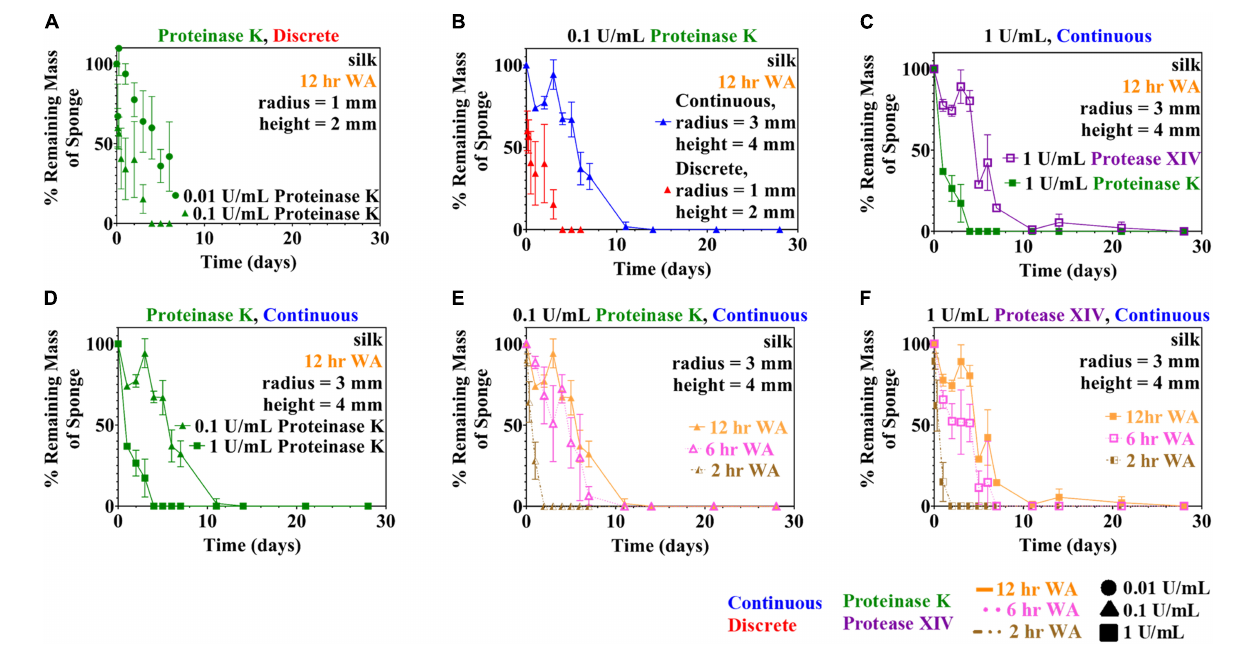
FIGURE 1 | Experimental quantitative changes of silk sponge mass during enzymatic degradation using two methods (discrete and continuous) are presented here. (A) Silk sponges were immersed in 0.01 and 0.1 U/mL using the discrete method to find the change in mass over time. Parameter estimation of modified first order rate constants was carried out using the data obtained in (A) . Silk sponges were immersed in Proteinase K at a concentration of 0.1 U/mL at 37 ◦ C and both experiment types were carried out: (B) continuous method and discrete method. (C) Using the continuous method, silk sponges were subjected to incubation with Protease XIV and Proteinase K at 1 U/mL and 37 ◦ C. Proteinase K (1 U/mL) increased the rate of degradation over Protease XIV (1 U/mL). (D) Silk sponges subjected to Proteinase K at 0.1 and 1 U/mL using the continuous method demonstrate silk degradation is dependent on the concentration of the enzyme. Sponges water annealed (WA) for 2, 6, and 12 h were immersed in (E) Proteinase K (0.1 U/mL) and (F) Protease XIV (1 U/mL). Degradation of 6 h WA annealed silk sponges was only slightly faster than degradation of 12 h WA silk sponges for both (E) Proteinase K (0.1 U/mL) and (F) Protease XIV (1 U/mL). The ordinate on all graphs is expressed as the mass of the sample divided by the starting point mass multiplied by 100. Data expressed by mean ± 1SD. Continuous method had biological replicates of n =3 and the discrete method had biological replicates of n